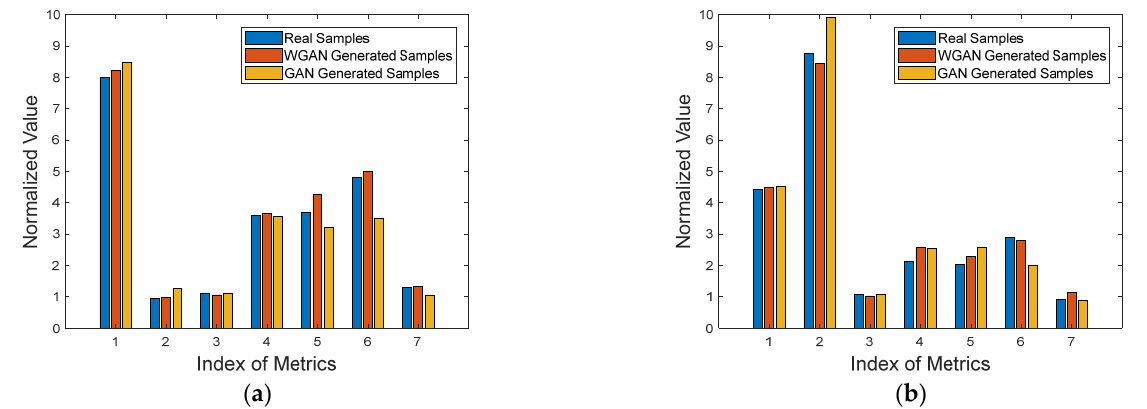
Figure 14. Bar graphs of the seven evaluation metrics of the generated samples from the database obtained from the measured data: ( a ) Pedestrian; ( b ) vehicle.